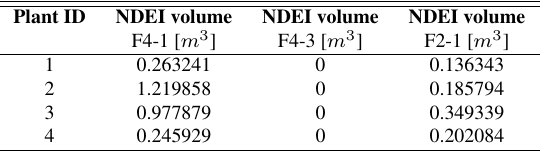
Table 9. Results of volume estimation in four plant removal areas. Volume units are cubic meters.